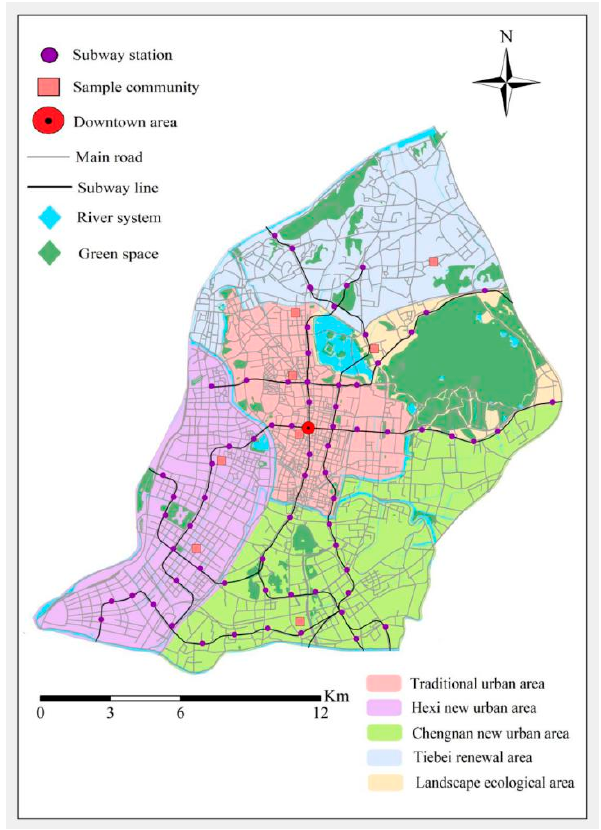
Figure 1. The study area and the location of sample community.